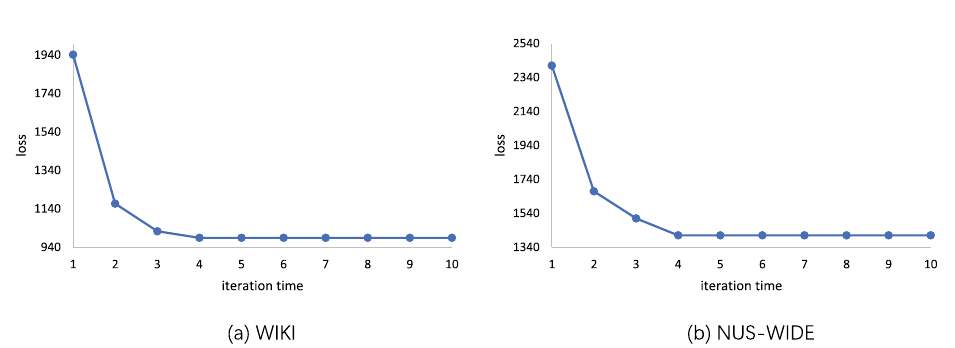
Figure 3. Convergence curves. We plot the convergence curves of iterative algorithm with respect to the loss value. With very few iterations, the losses become small and